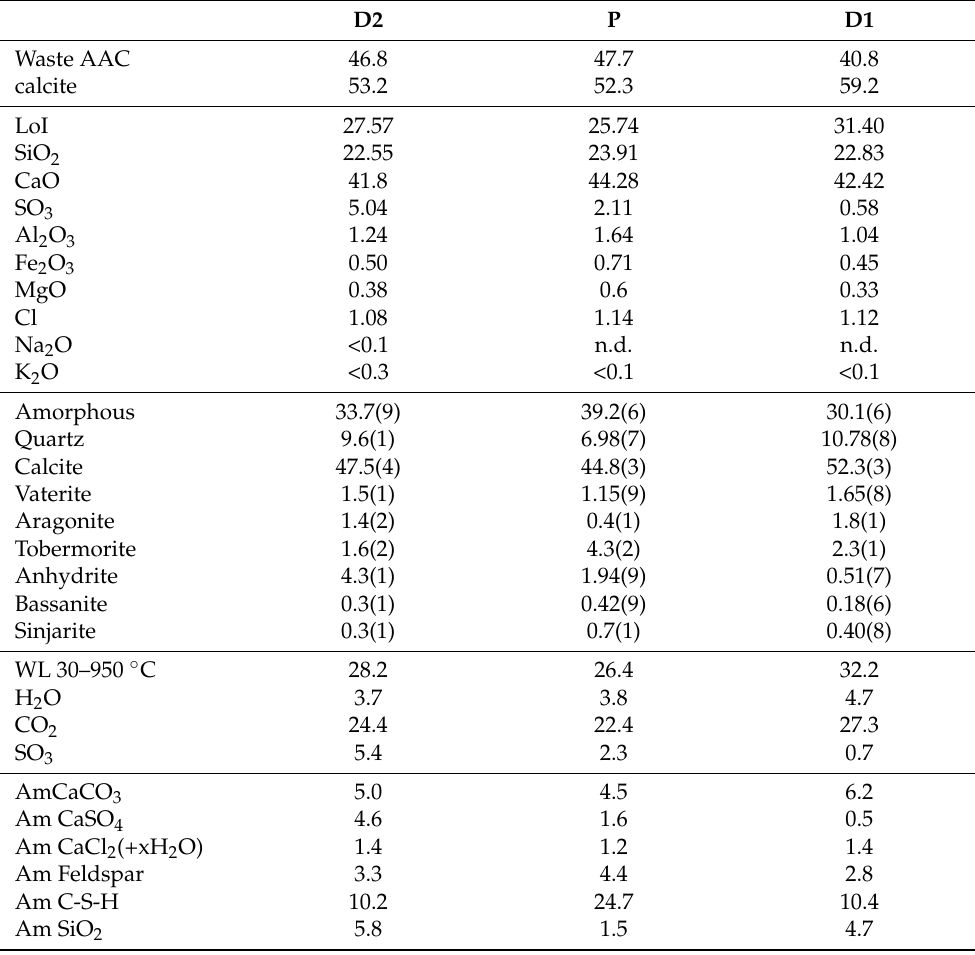
release from thermal analysis of the raw mixtures in wt%. Loss of Ignition-LoI. Additional